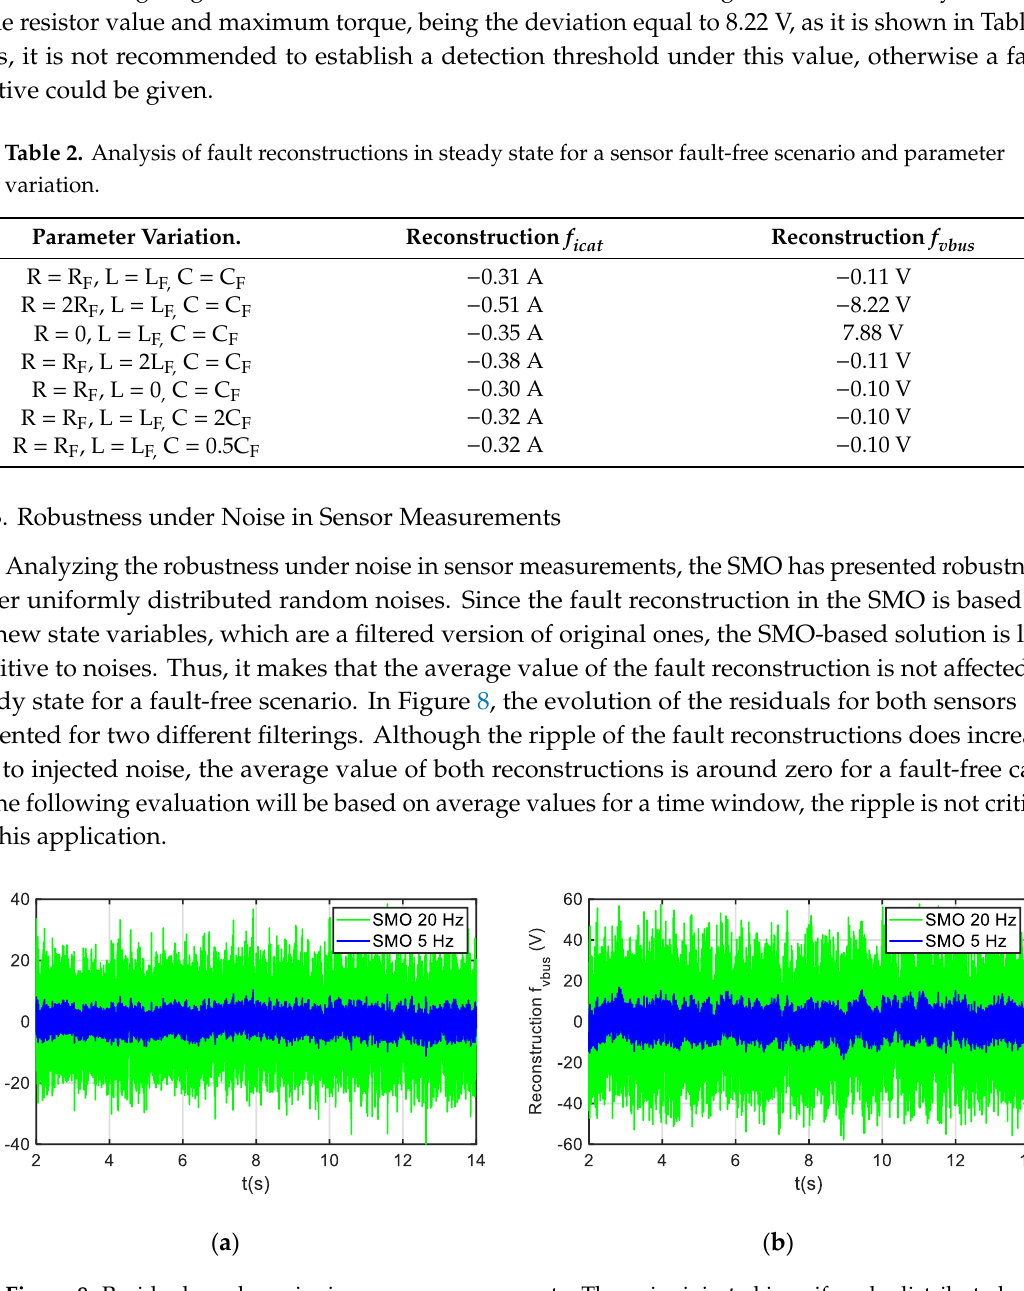
Figure 9. Hardware in the loop platform. In order to validate the FDD strategy, HIL simulations have been carried out for different operation points of the motor, as it is shown in Table 3. Several offset and gain faults have been MODEL OF THE PLANT